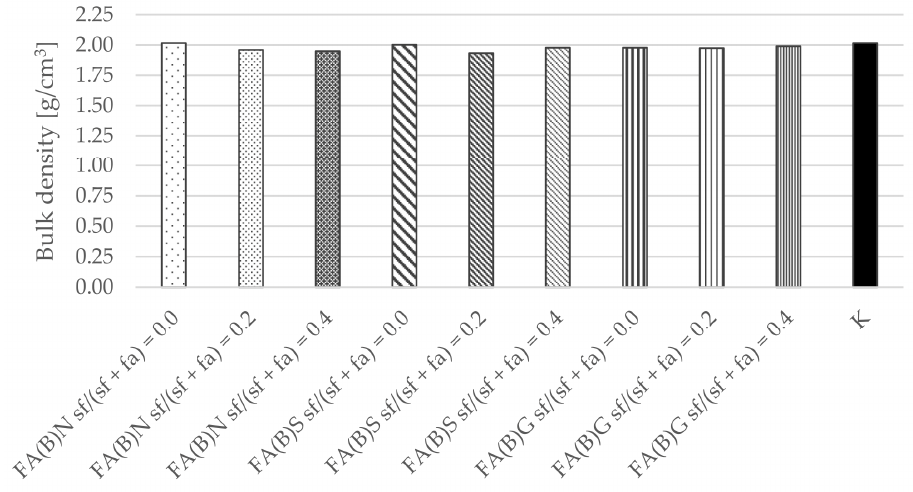
Figure 10. Bulk density of cement mortar with the addition of activated and untreated fly ash.